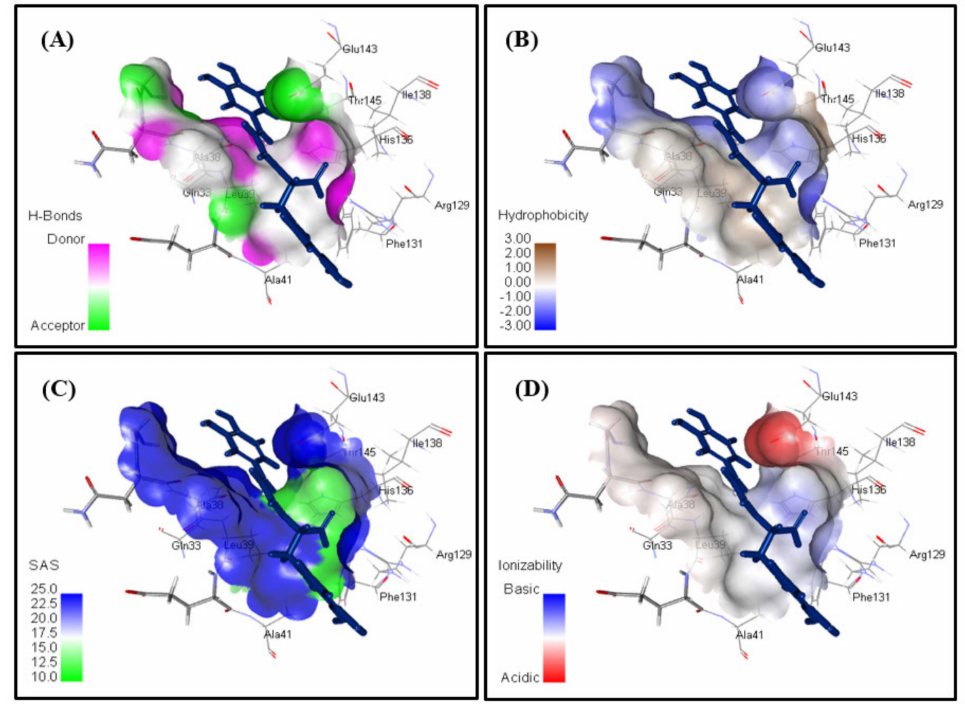
Figure 7. The presence of rosmarinic acid within the active pocket of Daf-2 protein illustrating ( A ) hy- drogen bond type, with receptor donors in green and receptor acceptors in cyan.; ( B ) hydrophobicity of the receptor residues, from blue for hydrophilic to brown for hydrophobic; ( C ) solvent accessibility of the receptor residues from blue for exposed to green for buried; and ( D ) the ionizability of the receptor residues, from blue for basic to red for